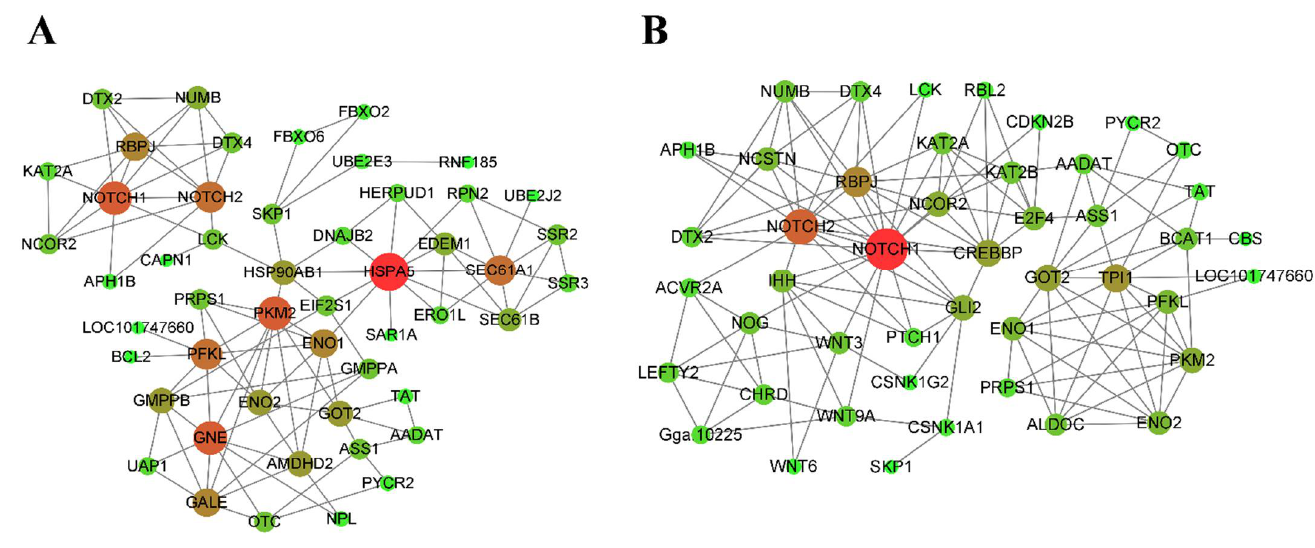
Figure 7. Interaction network analysis. ( A ) Networks of F14 vs. F20 comparison group; ( B ) networks of S14 vs. S20 comparison group.